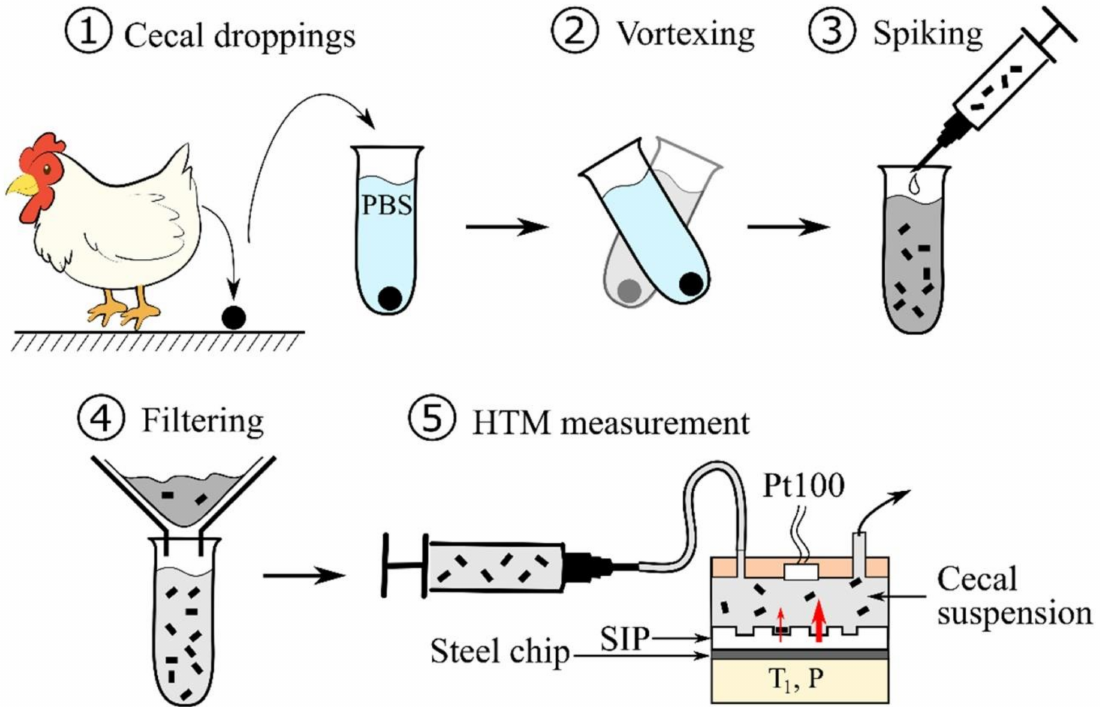
Figure 9. Schematic workflow of sample pre-treatment for Campylobacter detection in cecal dropping extracts with SIP-based HTM measurements; Reproduced with permission from [80], ©